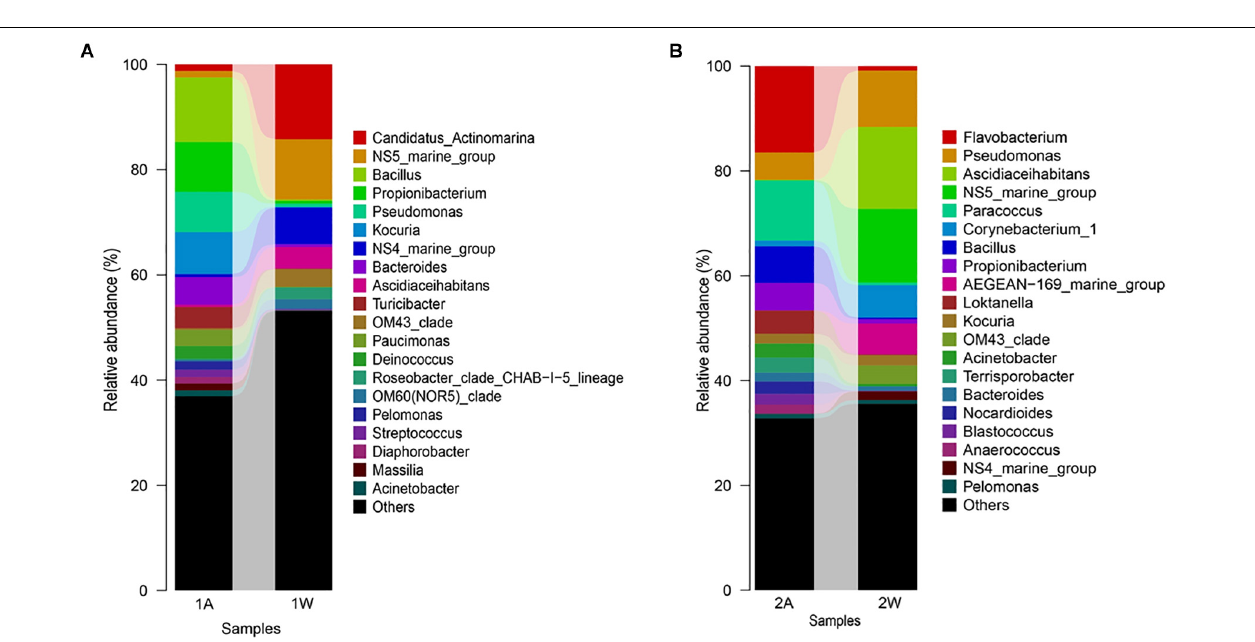
FIGURE 7 | Dendogram of similarity of all samples clustered by the UPGMA method. (A) Unweighted. (B) Weighted. The scale bar shows the distance between clusters in UniFrac units.